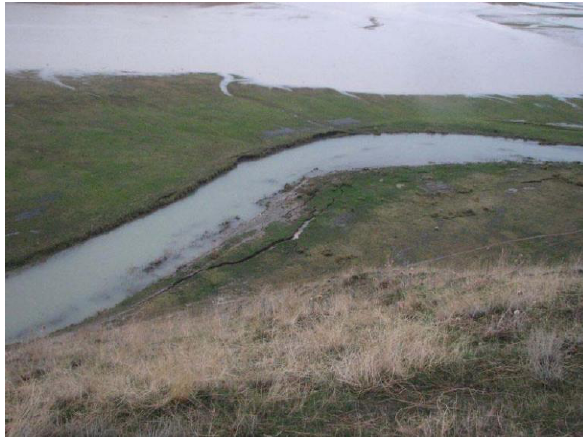
Figure 4. An example to lateral spreads from Van, Turkey, occurred after October 23 rd , 2011 earthquake (MTA, 2011).